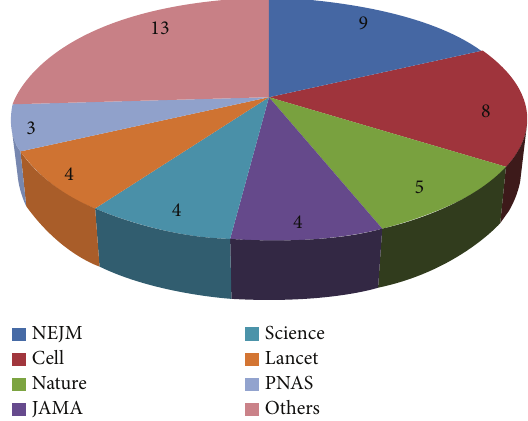
Figure 4: Distribution of journals.